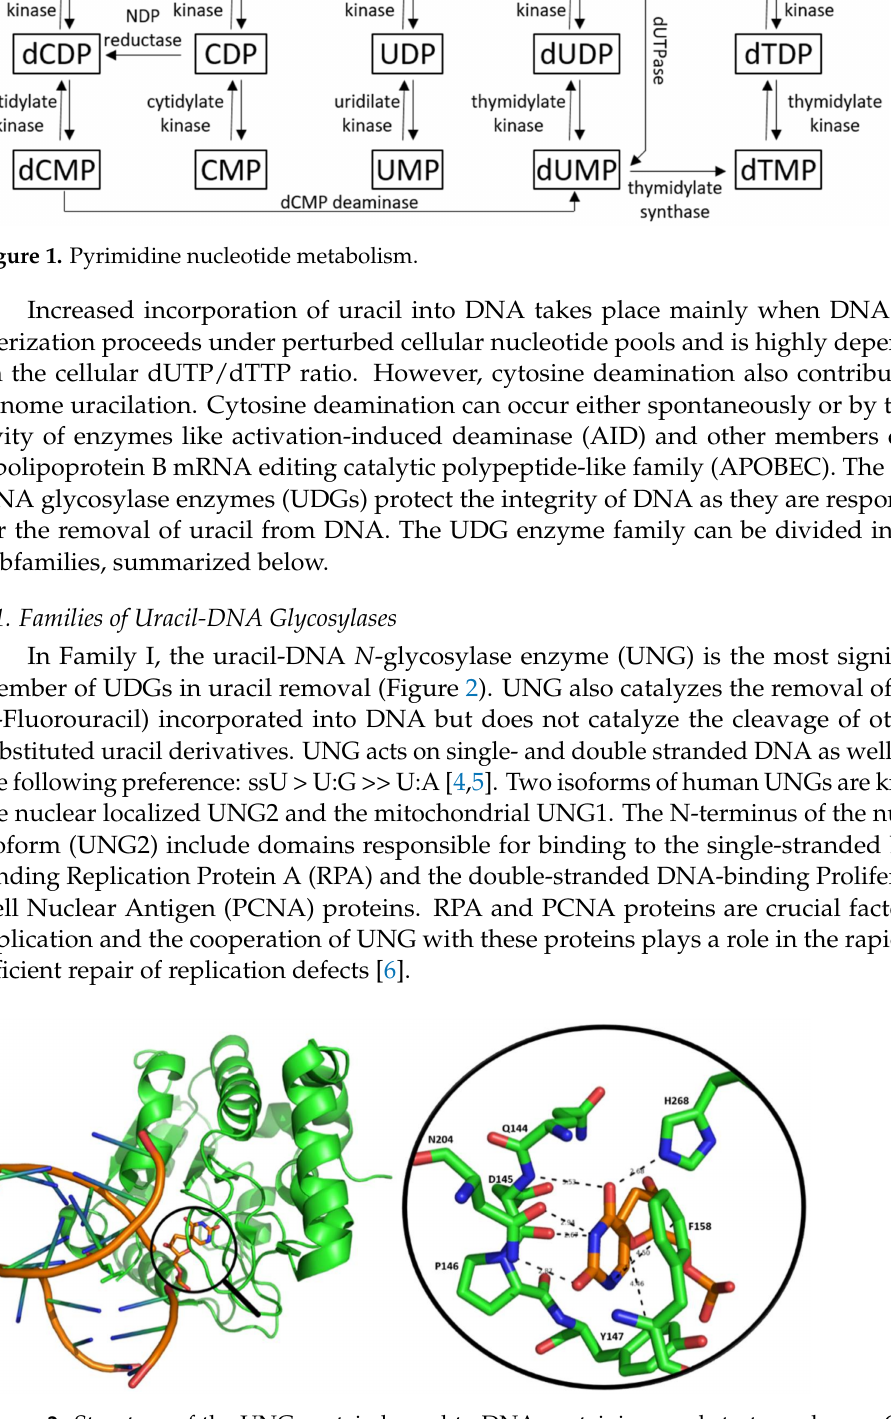
Figure 2. Structure of the UNG protein bound to DNA containing a substrate analogue. On the left: UNG enzyme protein (green ribbon model) binds DNA (orange ribbon model) containing the 2 (cid:48) -deoxy-pseudouridine-5 (cid:48) -monophosphate substrate analogue (stick model, atomic coloring: O: red, N: blue, P, C: orange) (PDB code: 1EMH). On the right: close-up of amino acids (stick model, atomic coloring: O: red, N: blue, C: green) which directly interact with the uracil base (stick model, atomic coloring: O: red, N: blue, P, C: